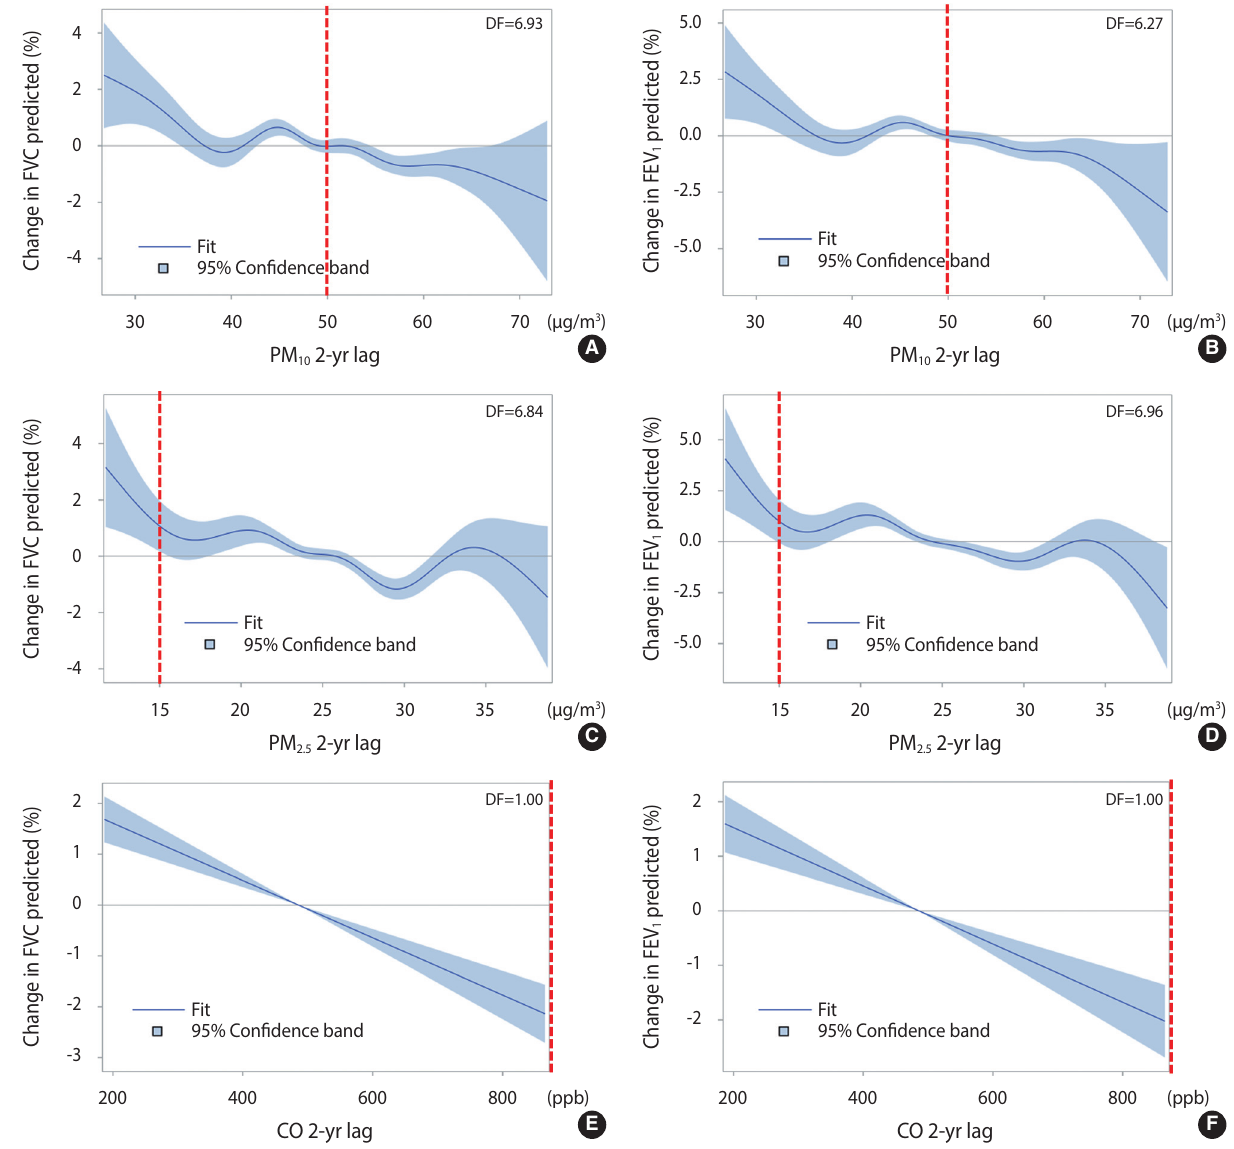
Figure 1. Changes in pulmonary function with increasing concentrations of air pollutants (PM 10 : A and B; PM 2.5 : C and D; CO: E and F) with spline terms using a generalized additive model. The red dotted lines indicate the standard atmospheric concentrations. PM 10 , particulate matter less than 10 μm in diameter; PM 2.5 , particulate matter less than 2.5 μm in diameter; CO, carbon monoxide; ppb, parts per billion; FVC, forced vital capacity; FEV 1 , forced expiratory volume in 1 second; DF, degree